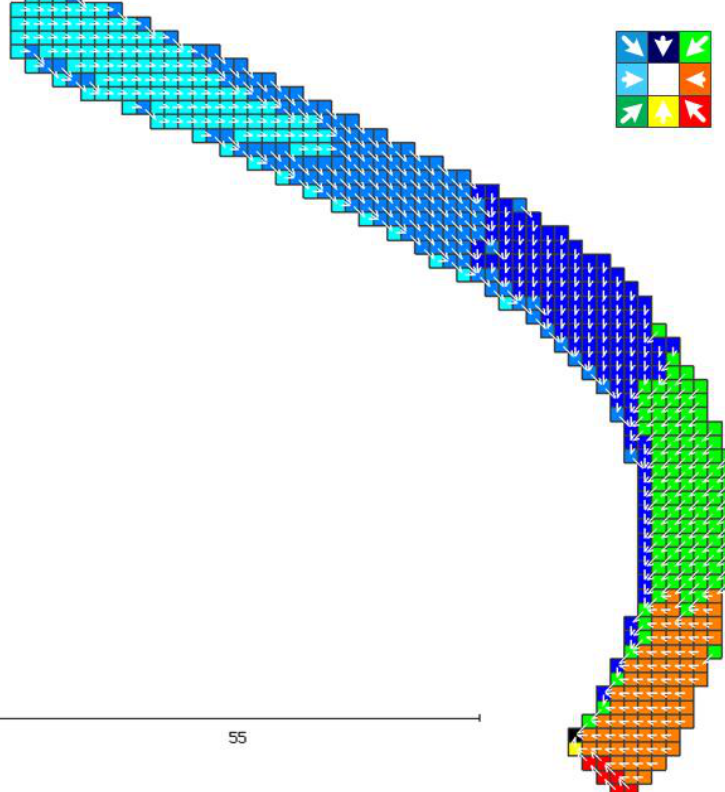
Figure 8: Road water flow directions on each grid